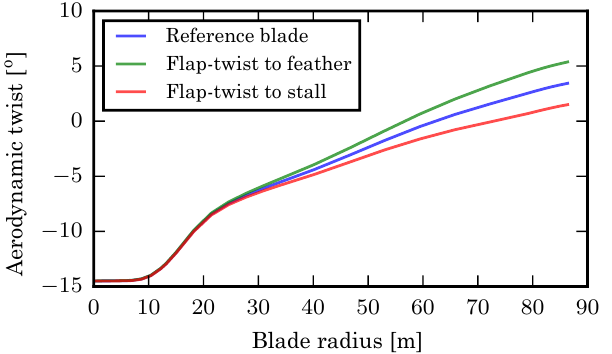
Figure 4. Pitch angles over wind speed for the reference and flap– twist to feather and stall coupled blades with coupling coefficients γ y = ± 0 . 1 constant along the